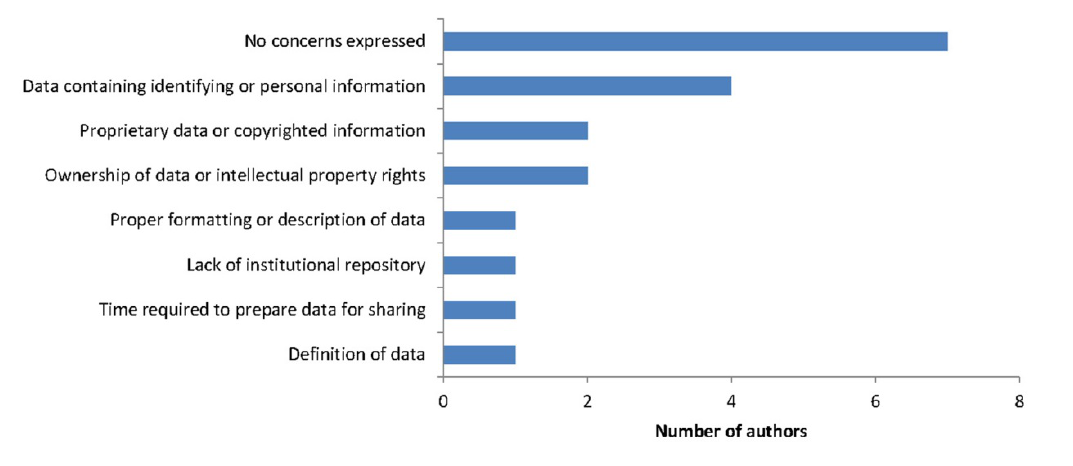
Figure 1 Concerns of authors regarding a potential Journal of the Medical Library Association data sharing policy